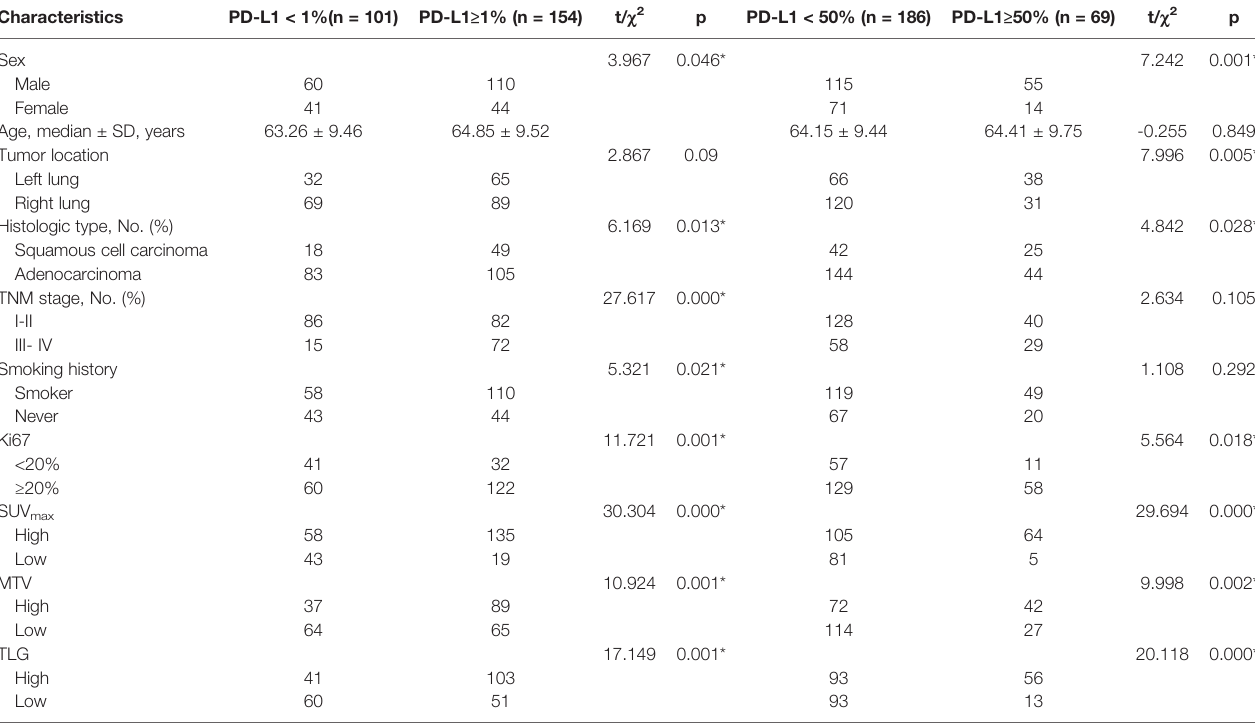
TABLE 2 | Characteristics of NSCLC patients with different PD-L1 expression levels.